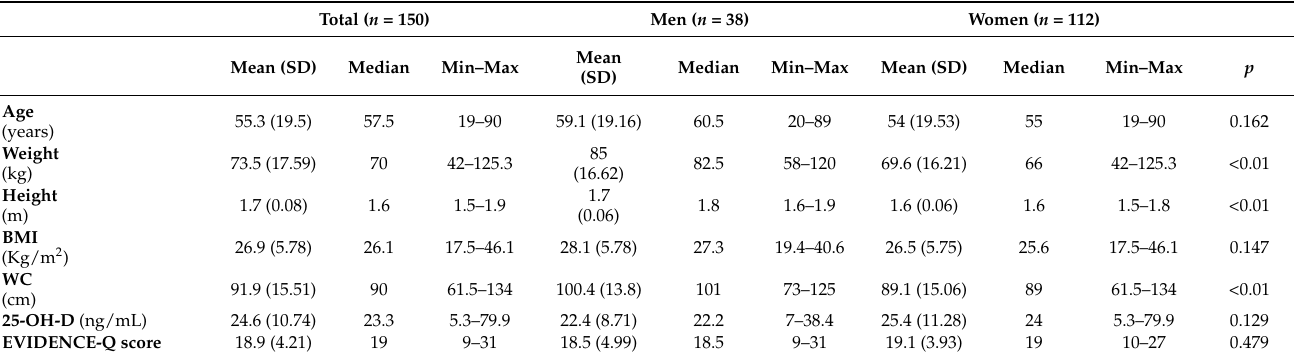
Table 1. General characteristics of the study population. Data are described as mean value and standard deviation (SD), median value and minimum (min) and maximum (max) values. Differences between men and women were also